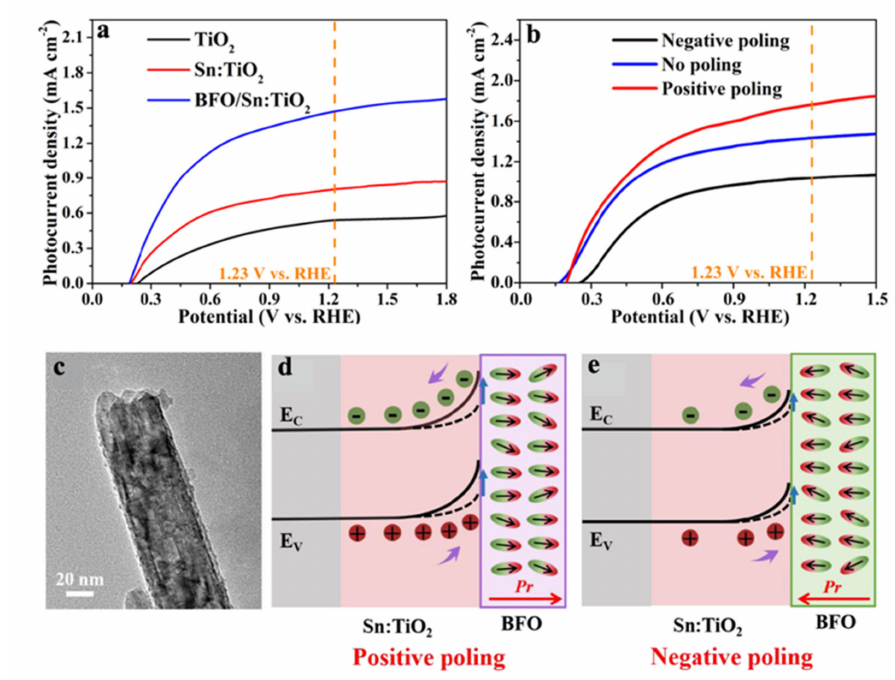
Figure 4. ( a ) LSV performance of TiO 2 , Sn–doped TiO 2 and BFO/Sn:TiO 2 NRs; ( b ) J − V curves of BFO/Sn:TiO 2 NRs with no poling, positive poling and negative poling; ( c ) TEM image of a single BFO/Sn:TiO 2 NRs; Schematic electronic band diagram of BFO/Sn:TiO 2 NRs with ( d ) positive poling, and ( e ) negative poling. Adapted with permission from ref. [70], copyright: 2019,